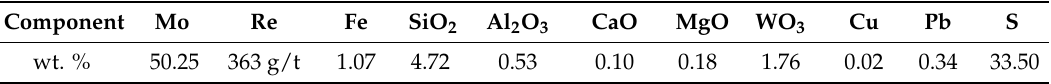
Table 2. Main chemical composition of molybdenite concentrate after pretreatment. Component